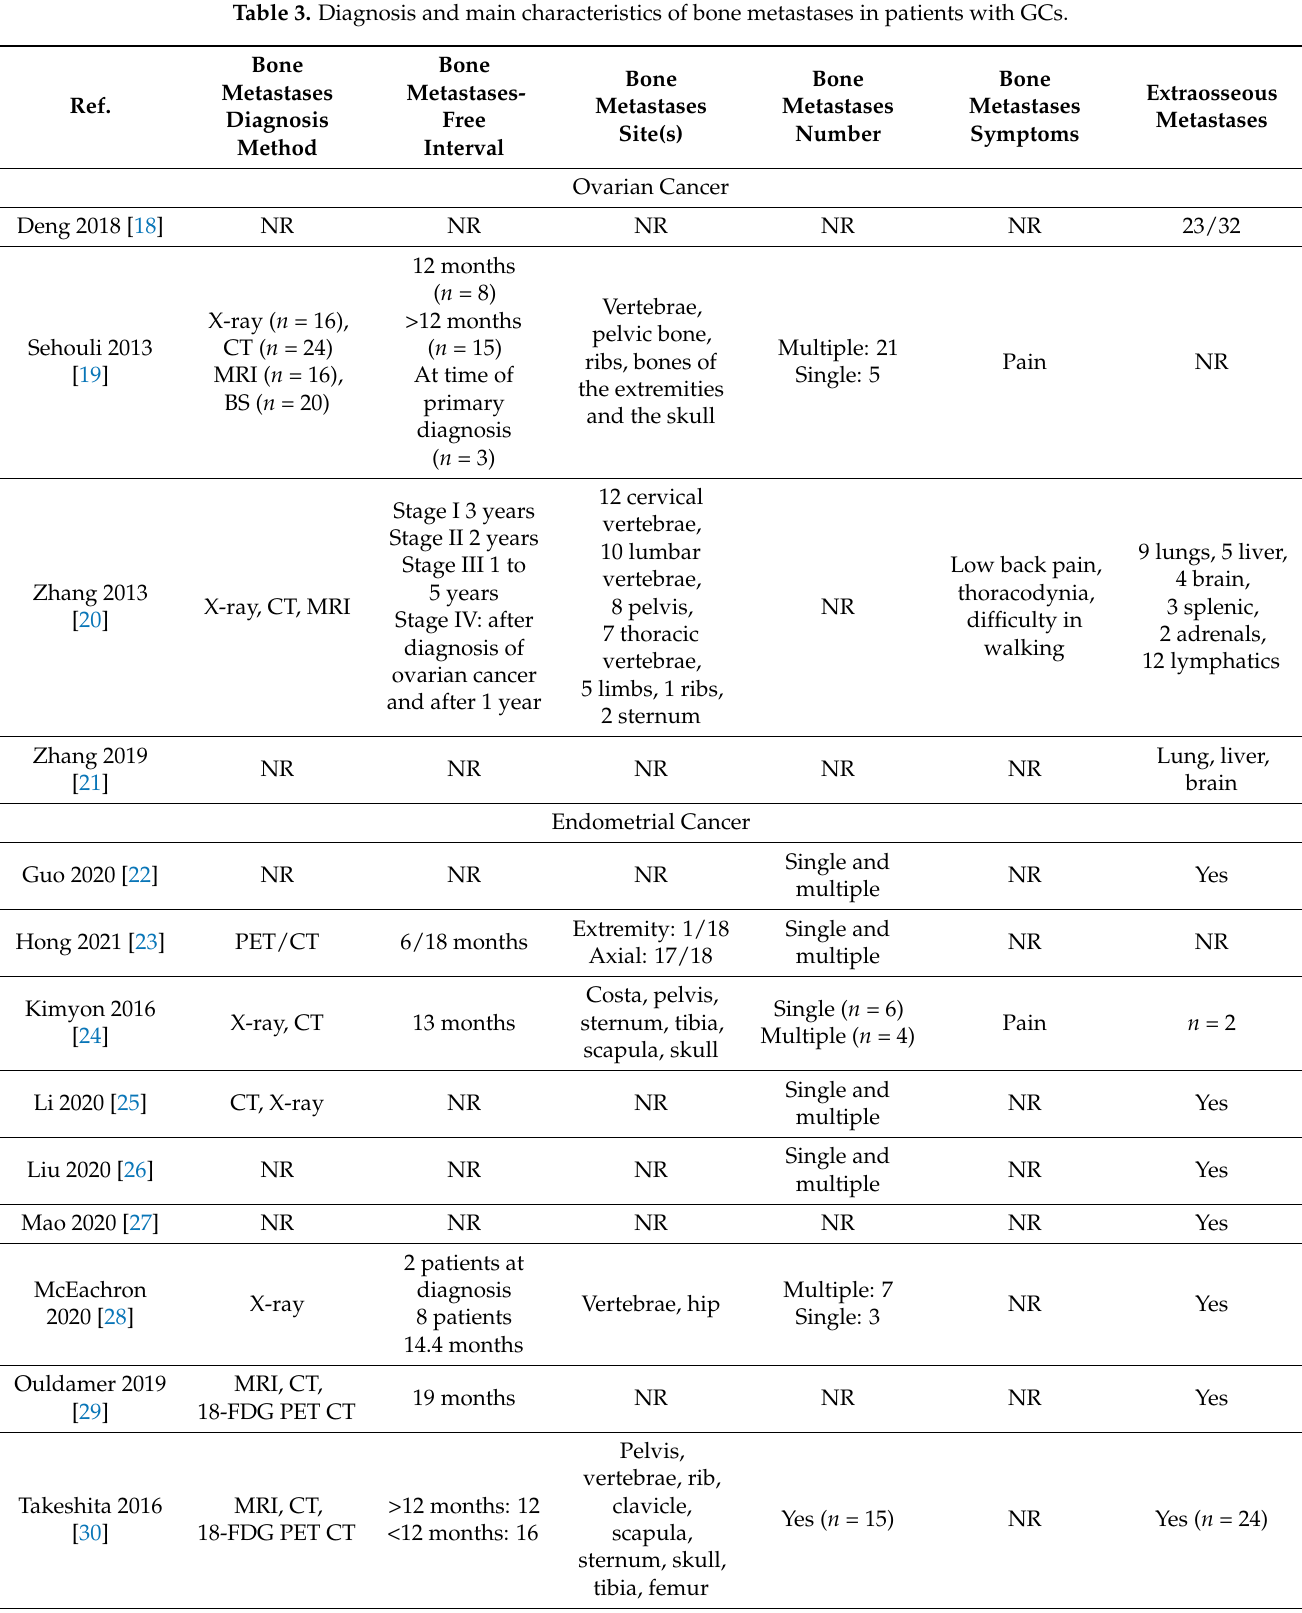
Table 3. Diagnosis and main characteristics of bone metastases in patients with GCs.